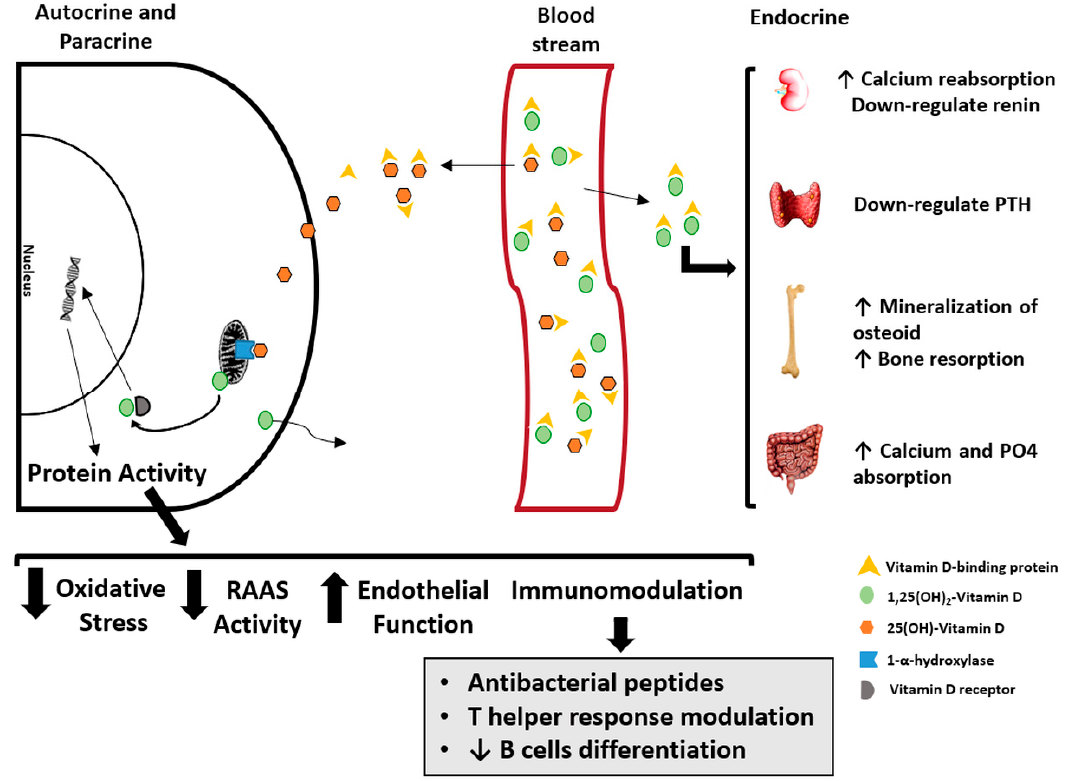
Figure 3. Schematic model of the classical and non-classical effects of vitamin D. The compounds 25(OH)-VD and 1,25(OH) 2 -VD circulate mainly bound to the vitamin D binding protein (VDBP). The endocrine effects of 1,25(OH) 2 -VD are represented on the right. Different types of cells can present the machinery for 25(OH)-VD activation (left). In an autocrine and paracrine fashion, 1,25(OH) 2 -VD regulates the transcription of pivotal proteins involved in several biological processes (left). RAAS = renin-angiotensin-aldosterone system. PTH = parathyroid